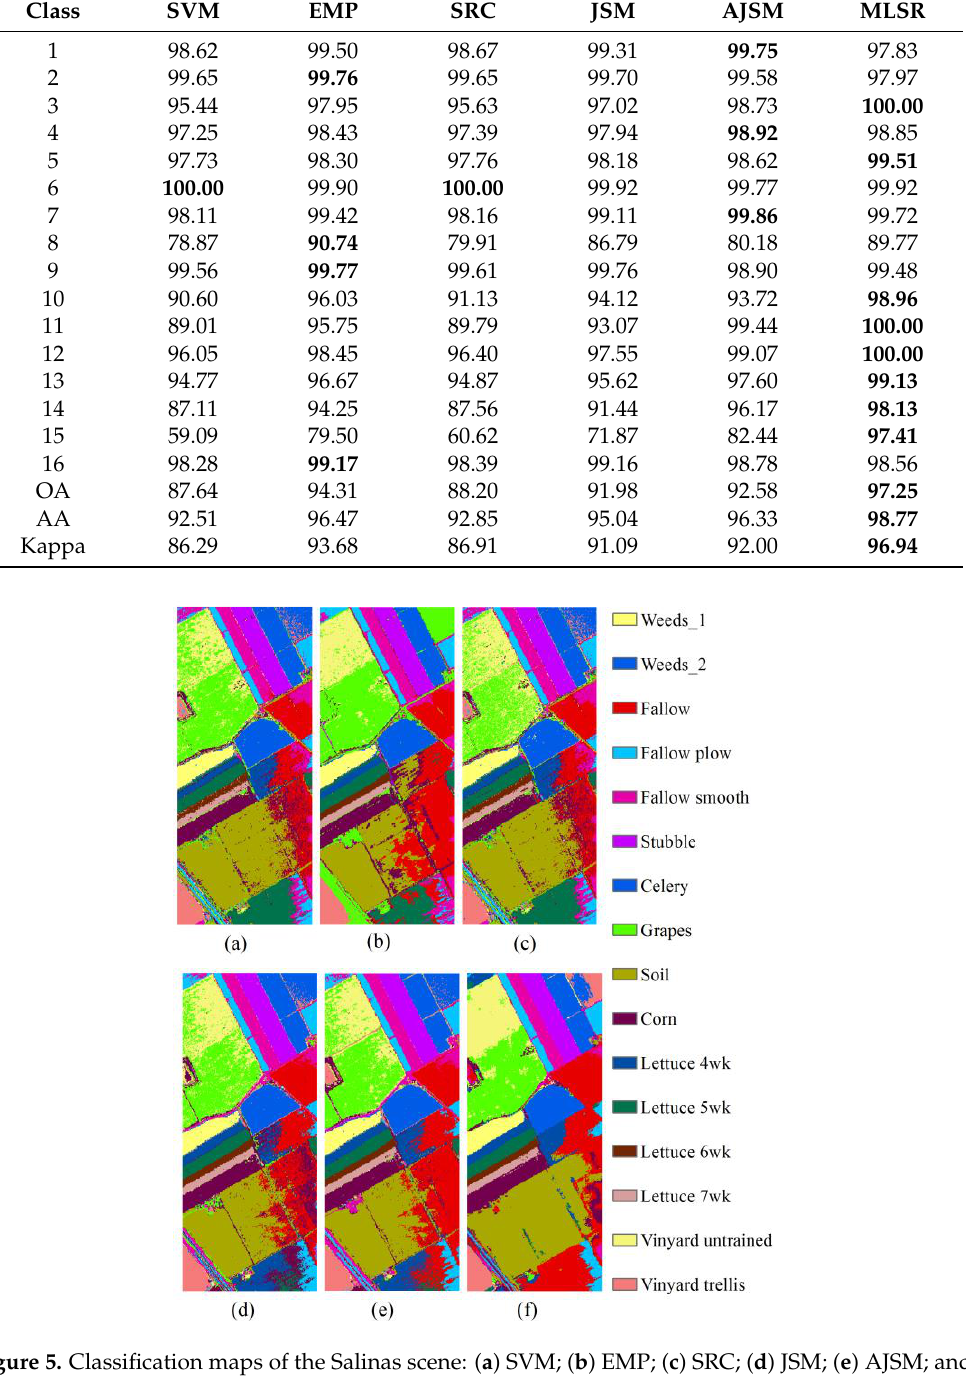
Figure 5. Classification maps of the Salinas scene: ( a ) SVM; ( b ) EMP; ( c ) SRC; ( d ) JSM; ( e ) AJSM; and ( f ) MLSR.